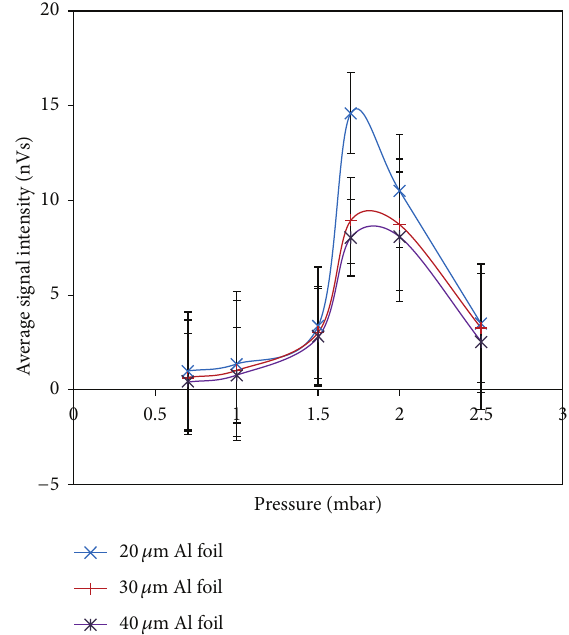
Figure 6: Variation of average signal intensity recorded by Al foil (20 𝜇 m, 30 𝜇 m, and 40 𝜇 m) versus Argon gas pressure.